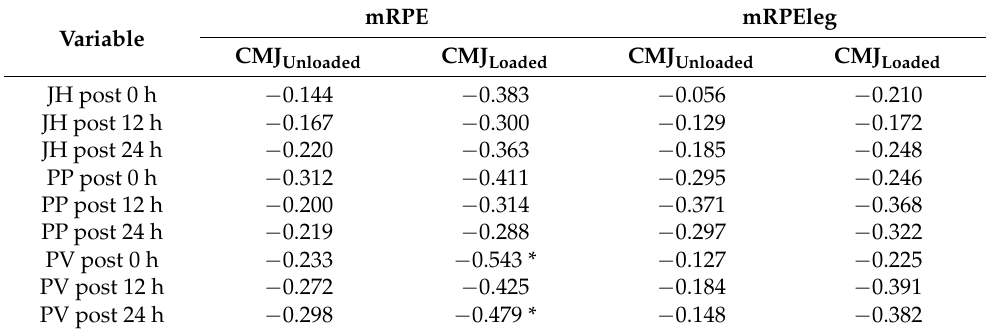
test, post 0 h; 12 h after countermovement jump test, post 12 h; 24 h after countermovement jump test, post 24